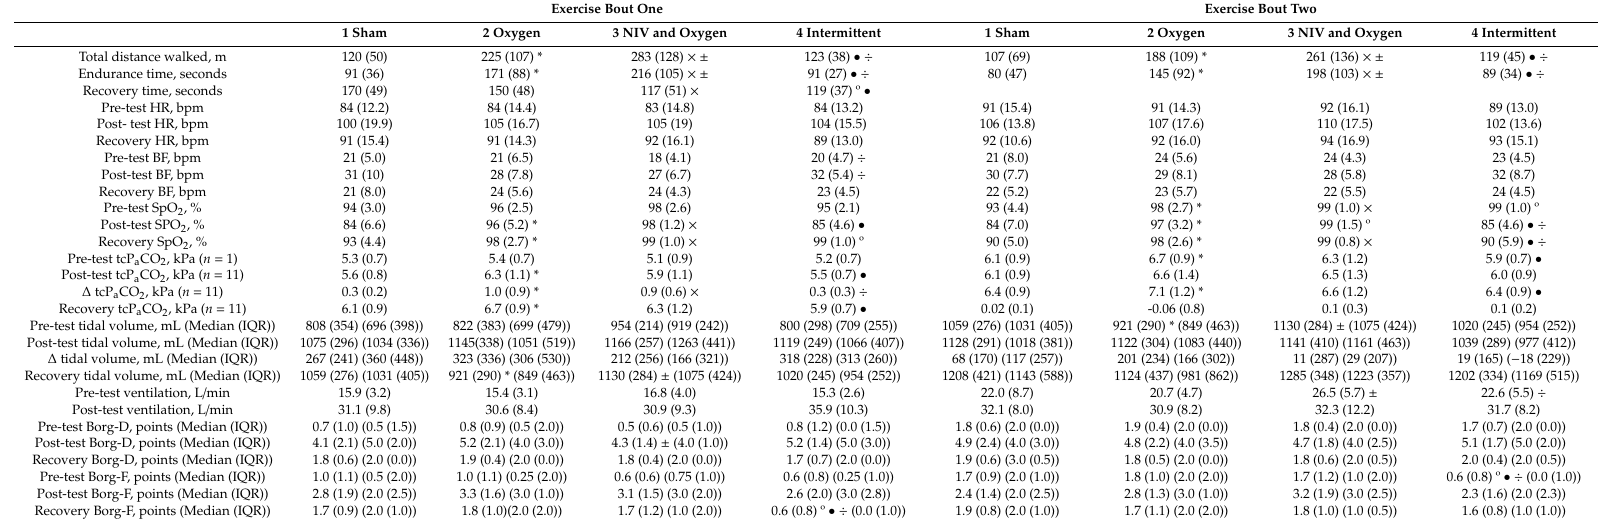
Table 2. Results of 13 COPD patients with hyperinflation and exertional oxygen desaturation completing four sets of treadmill tests with di ff erent settings of the